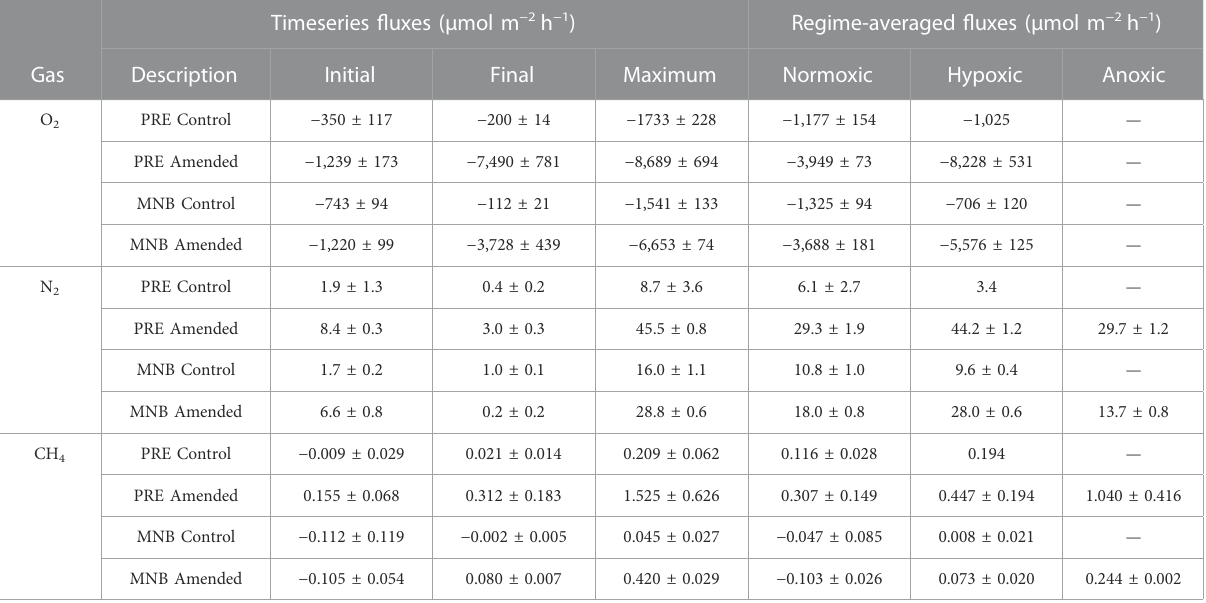
TABLE1Comparisonofbenthicgas fl uxesforeachsiteandtreatmentduringnormoxic,hypoxic( ≤ 94 μ M),andanoxicconditions.Valuesrepresentthemean± standard error of the fl uxes measured for the up to three replicate cores in each incubation. For the timeseries fl uxes, the initial fl ux is that measured 1 hinto the incubation, the fi nal fl ux is that measured at the end of the incubation, and the maximum fl ux is the maximum in fl ux (O 2 ) or ef fl ux (N 2 and CH 4 ) attained during the incubation. The regime-averaged fl uxes were calculated from the difference in fi tted concentrations between the beginning and end of each oxygen regime. If no standard error is reported then only one core reached hypoxia. If no value is reported then none of the cores reached anoxia.